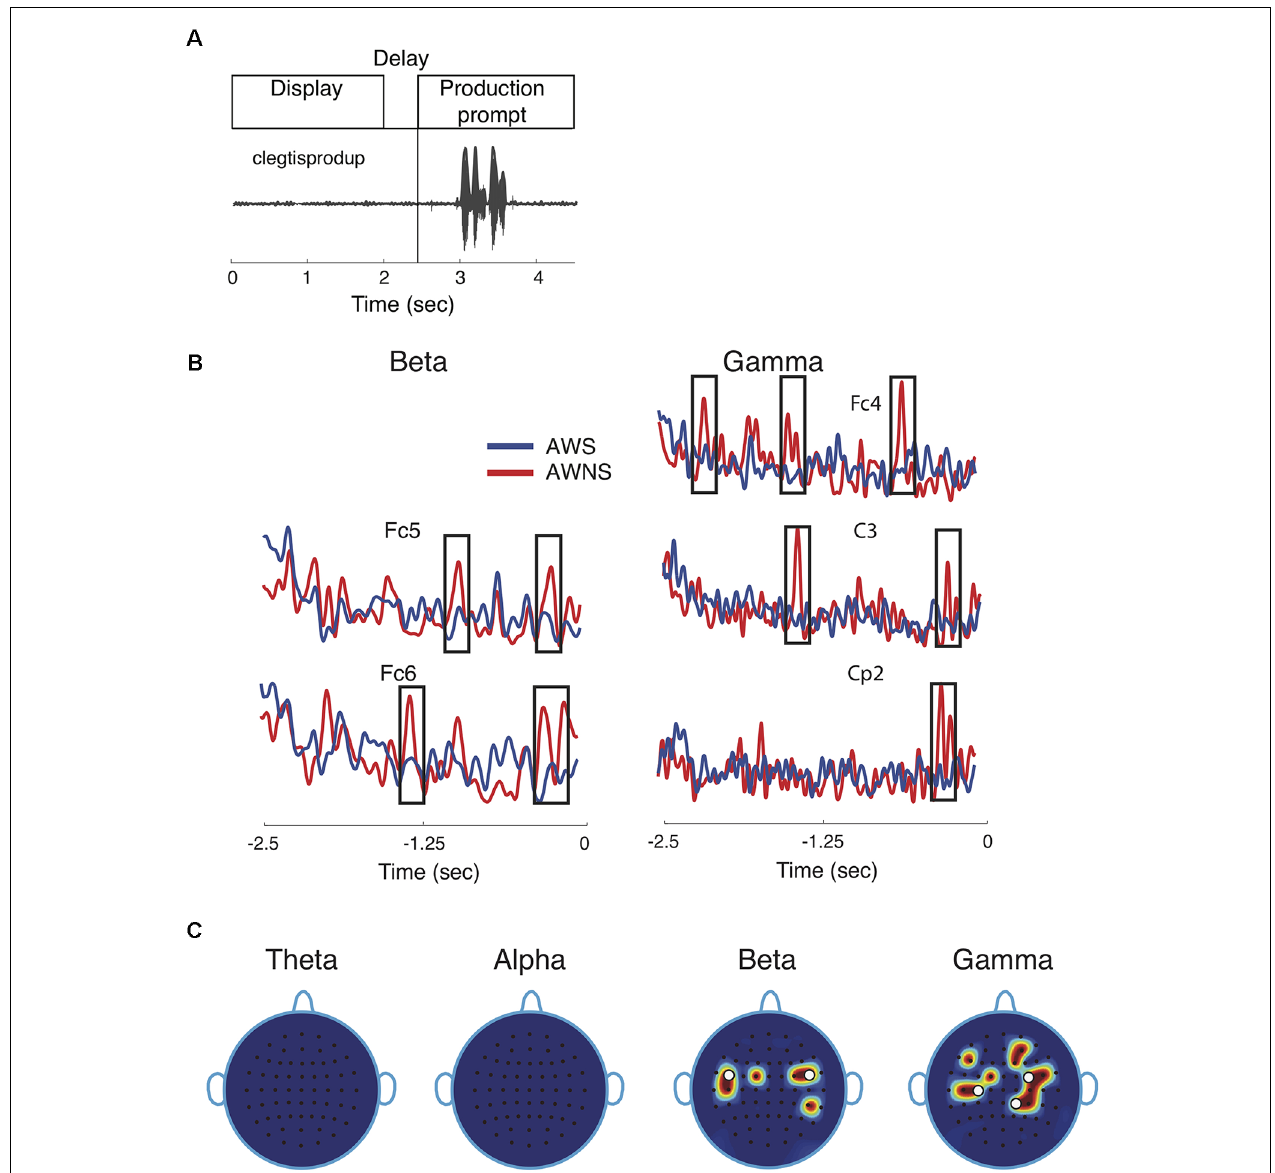
FIGURE 1 | Speech task and spectral power results. (A) Participants performed a delayed reading task in which target utterances were displayed for 2 s, followed by a prompt to read the displayed utterance aloud after a 0.5 s delay. The speech waveform corresponding to the utterance “clegtisprodup,” is shown. (B) Representative power traces for beta and gamma band are shown for adults who stutter (AWS; blue) and adults who do not stutter (AWNS; red). The 2.5-s portion of the power trace from the start of the word display to the appearance of the production prompt is shown at 0 s. Significant differences are shown to occur in time windows marked by rectangular windows. (C) Scalp electrode locations display significant power differences between the two groups. Effects were observed for beta band at electrode locations Fc1, Fc5, C5, Fc2, Fc4 and Cp4 and for gamma band at Fc1, C3, C5, Fc4, Fc6, C4, Cp2, Cp4, F5, F2, and Af4. White circles denote electrode locations that showed differences in phase